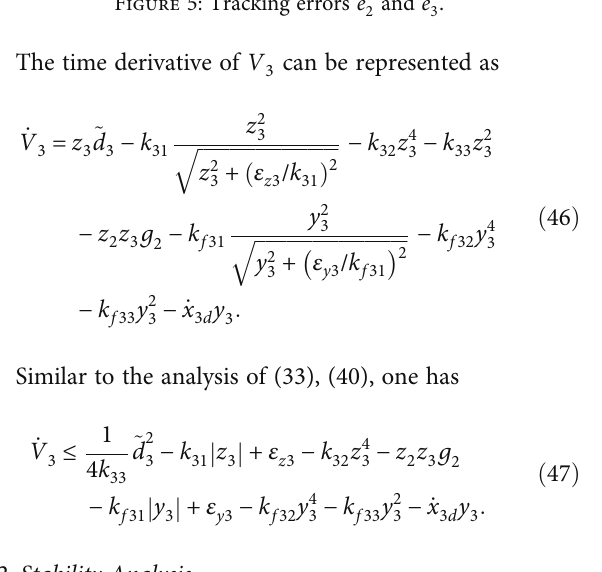
Figure 5: Tracking errors e